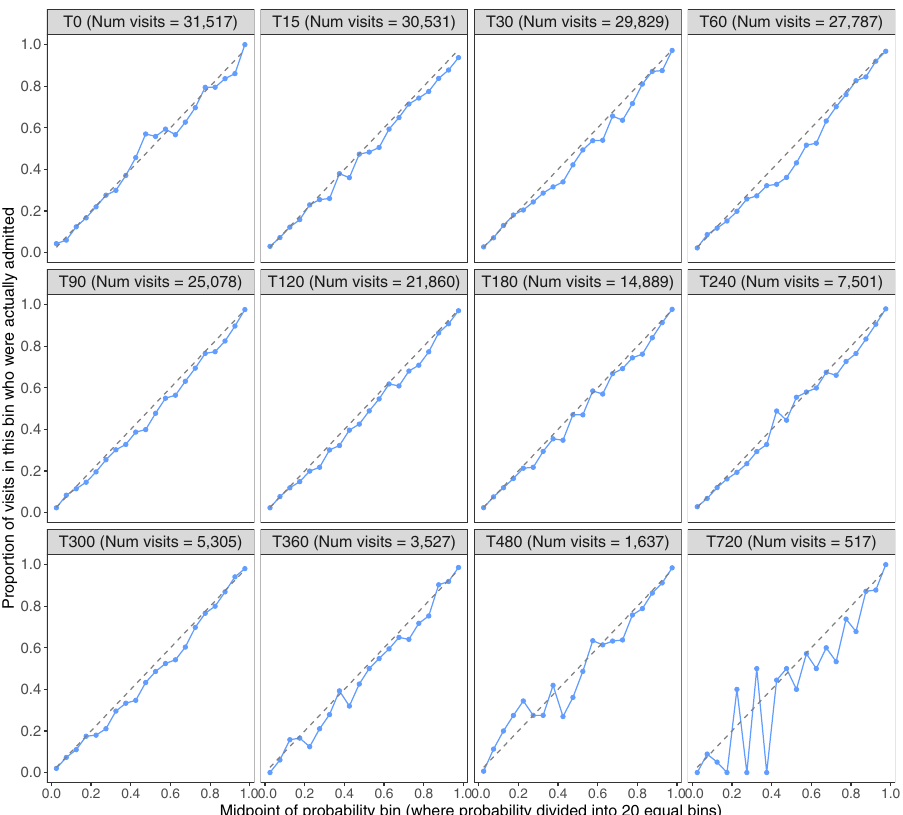
Fig. 3 Calibration plots for each of the ML models applied to test set. For each of the 12 models (T0 to T720) a calibration plot is shown. All visits whose duration exceeds the cut off time for each model (eg, for the T15 model, all visits lasting more than 15 mins) are included.